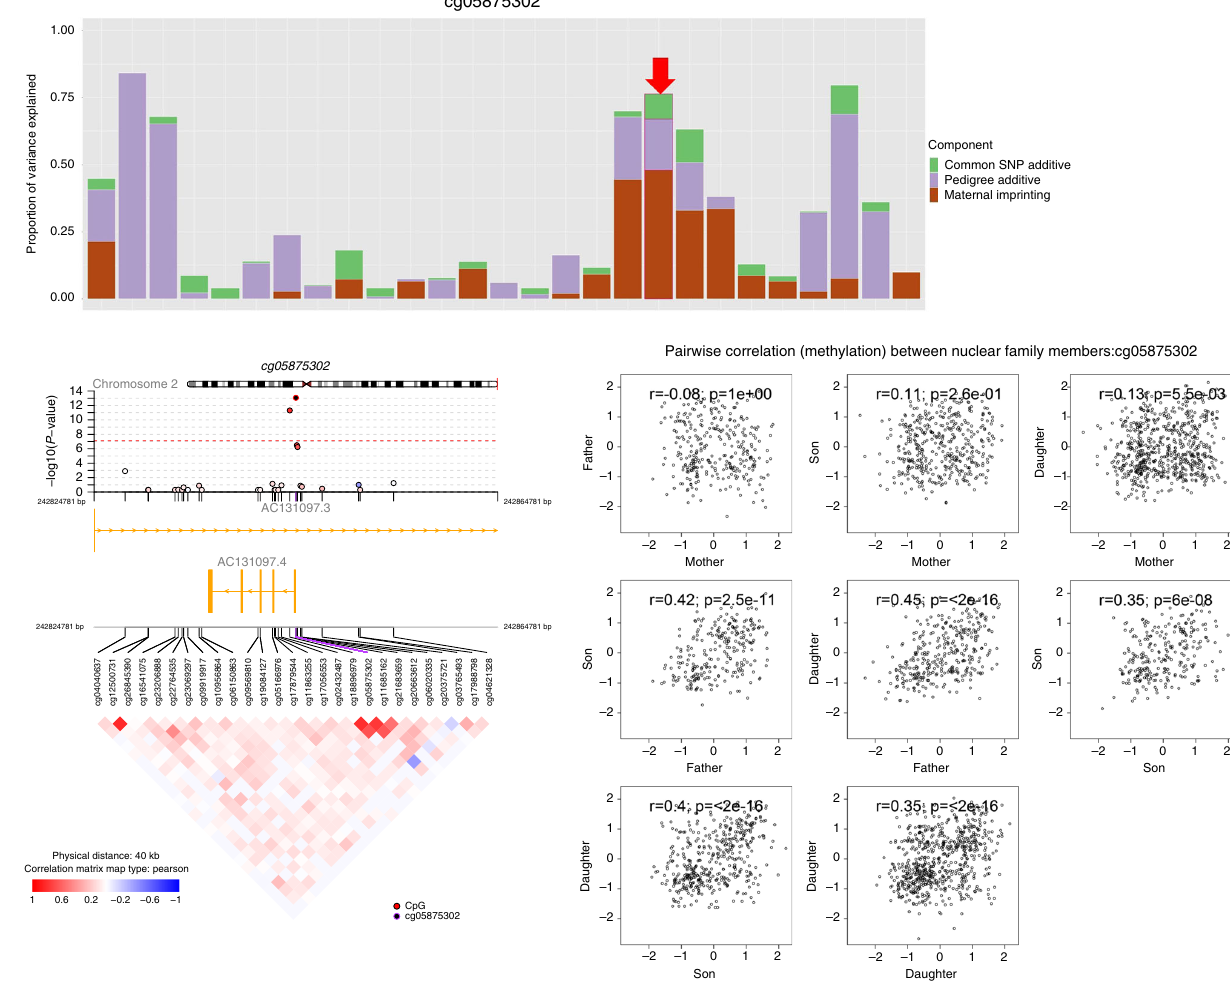
Fig. 2 Example of a novel CpG site (cg05875302) in fl uenced by maternal imprinting POE. Upper panel: bars represent estimated variance explained by each component in the selected model for the site displaying signi fi cant maternal imprinting (cg05875302, red arrow) and the sites within 20 kb on either side of the selected site. Bottom left panel: regional plot of – log e ( p -value from LRT) of the POE in the selected (red ringed black dot) and surrounding CpG sites with matrix of pairwise correlations of methylation level between these sites in the heatmap below. Bottom right panel: pairwise correlation between methylation M values (corrected for technical and biological covariates) between different pairs of nuclear family